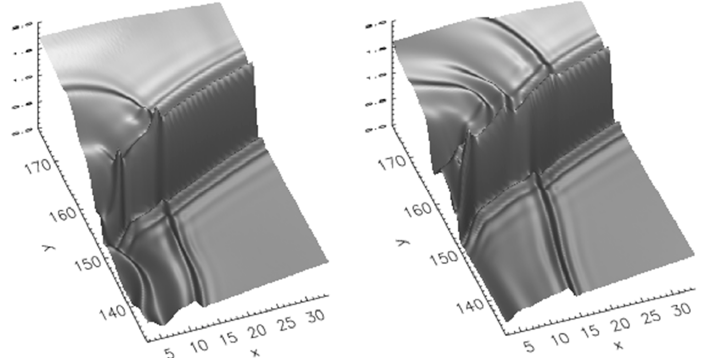
Figure 11. Pressure perturbation P T in the ( x , y ) -plane for the case V 0 = 4.6 and ∆ n = 0.7 at t = 360 ( left ) and at t = 365 ( right ). Due to the different conditions upstream and downstream the shocks, the perturbations originated at the edge of vortex propagate in the x -direction with different velocities in the two regions of the